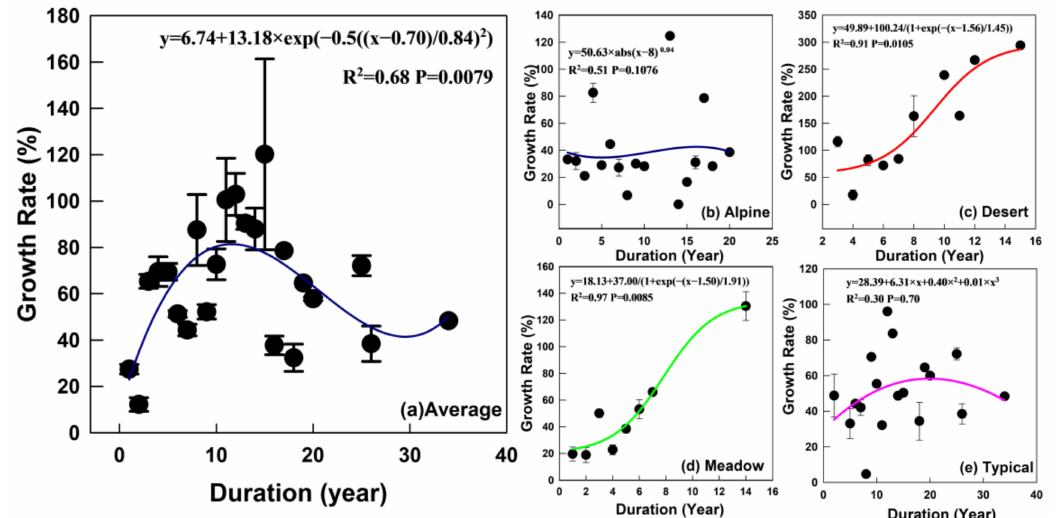
Figure 2. The growth rate of vegetation coverage across the enclosed grasslands ( a ) and in specific grassland types ( b – e ). Error bars are 95% bootstrapped confidence